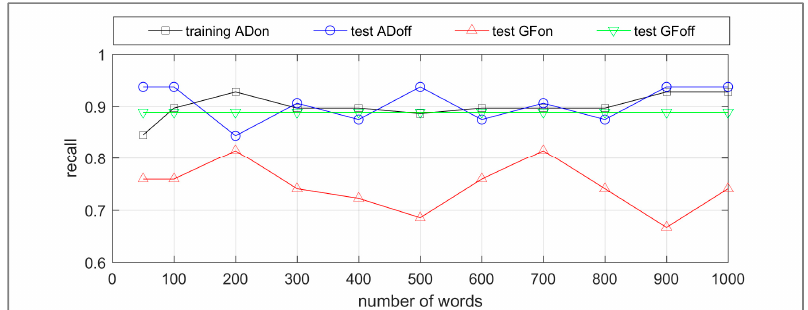
Figure 12. Precision of the SVM classifier for the WA OTG class when trained with images of the ADon dataset and tested on images of the ADoff, GFon and GFoff datasets against vocabulary size. Figure 11. Recall of the SVM classifier for the WA OTG class when trained with images of the ADon dataset and tested on images of the ADoff, GFon, and GFoff datasets against vocabulary size.